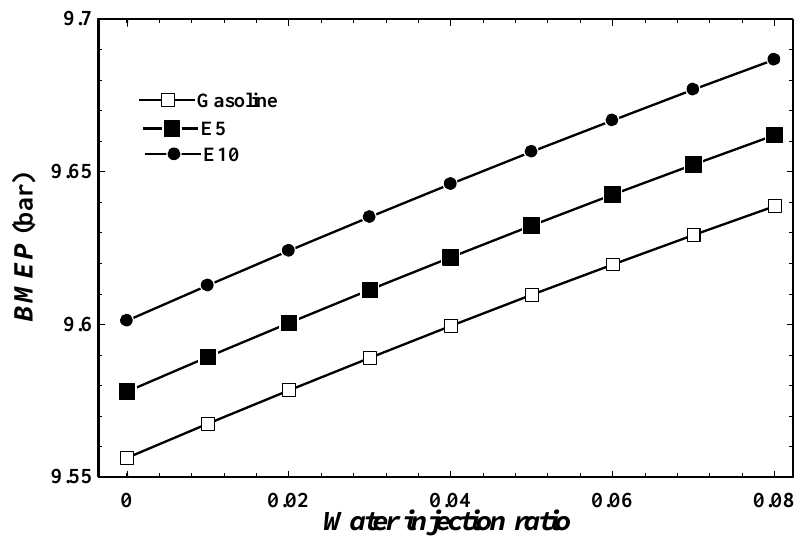
Figure 7. Engine BMEP in various water injection ratios for each fuel.